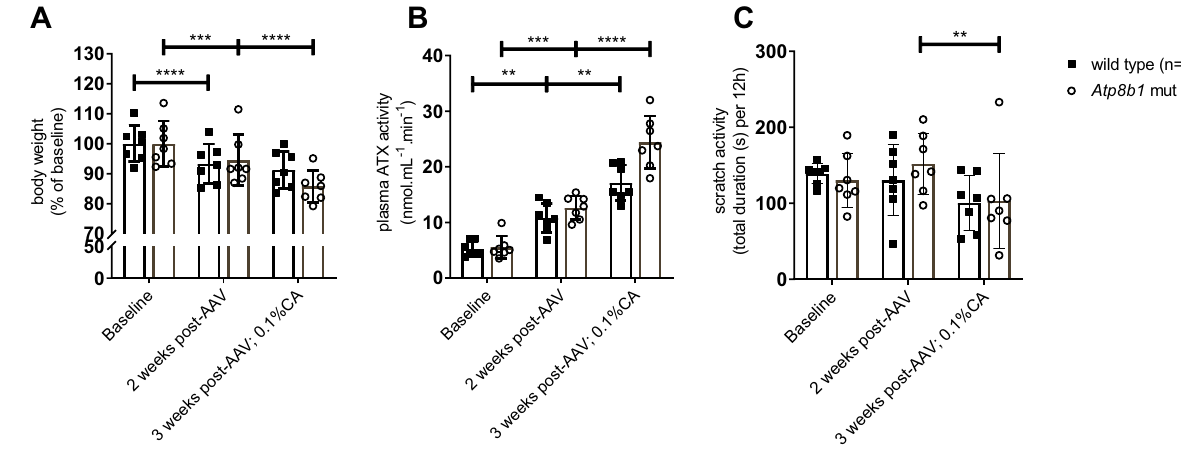
Figure 5. Inducing ATX activity by AAV8-CMV-ATX transduction does not increase scratch activity. Body weight ( A ), plasma ATX activity ( B ) and scratch activity ( C ) were measured during baseline, 2 weeks after AAV8-CMV-ATX injection and 3 weeks after AAV8-CMV-ATX injection combined with 0.1% CA diet for one week in both WT and Atp8b1 mutant mice (n = 7). Bars depict mean ± SD. Statistics: paired t-test within groups, *indicates p -value < 0.05; **indicates p -value < 0.01.